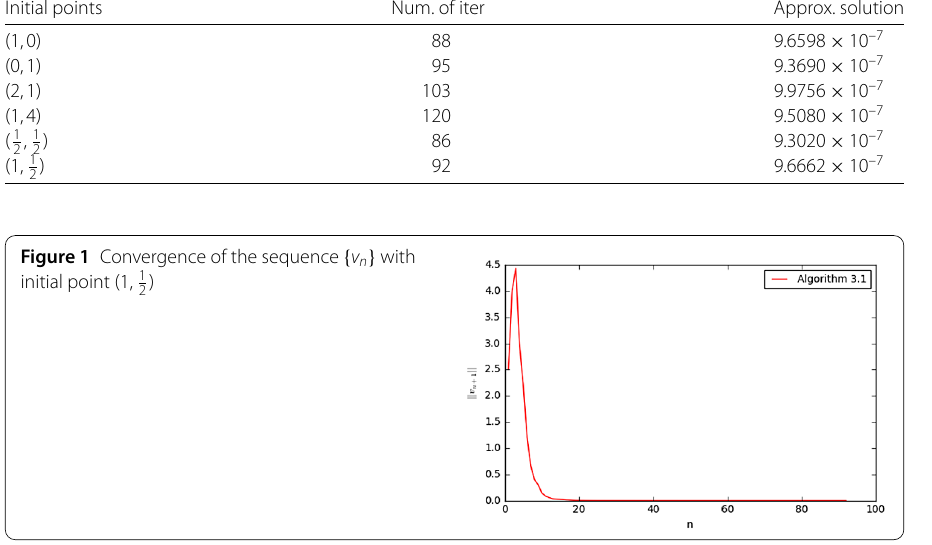
Table 1 Numerical illustration for the zero of a generalized- φ -strongly monotone map Initial points Num. of iter